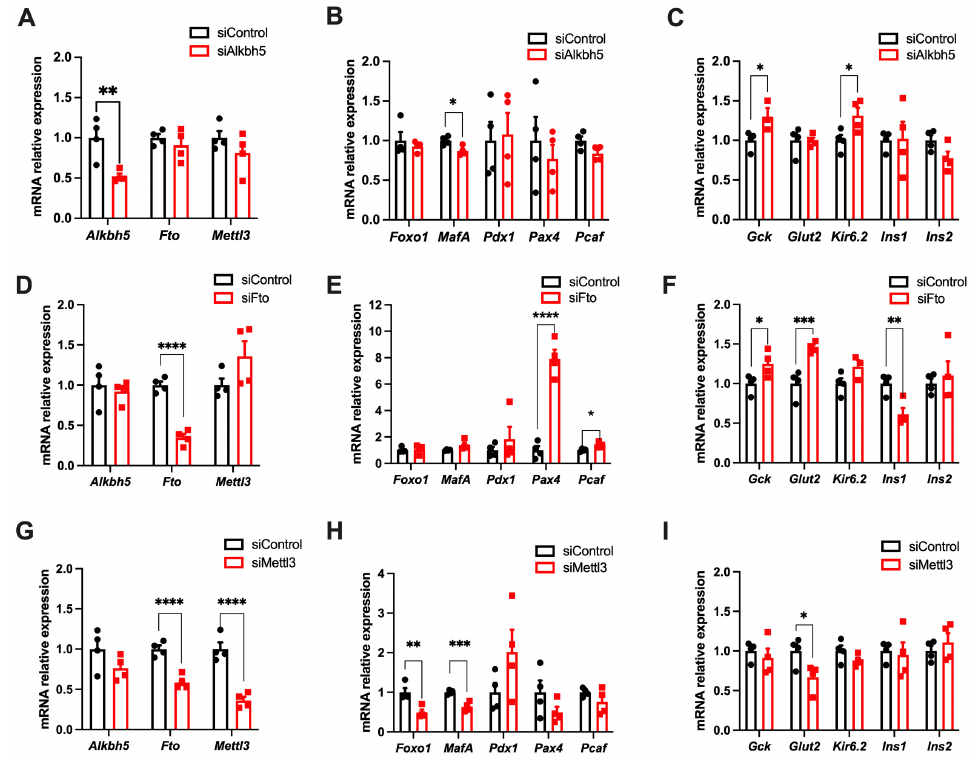
Figure 6. Knock-down of m 6 A enzymes through siRNA affects the expression of genes involved in beta-cell identity and function. Cells were treated during 24 h with a non targetting siRNA (siControl), siAlkbh5, siFto and siMettl3 and lysed 48 h later to study mRNA expression. Quantification of m 6 A enzyme expression by RT-qPCR after siRNA transfection against Alkbh5 ( A ), Fto ( D ) or Mettl3 ( G ) ( n = 4). mRNA expression of genes involved in β -cell identity ( B , E , H ) and function ( C , F , I ) ( n = 4) is represented. Data were analyzed by two-way ANOVA with Bonferroni’s correction for multiple comparisons ( A , D , G ) and multiple t-tests ( B , C , E , F , H , I ). * p < 0.05, ** p < 0.01, *** p < 0.001, **** p <